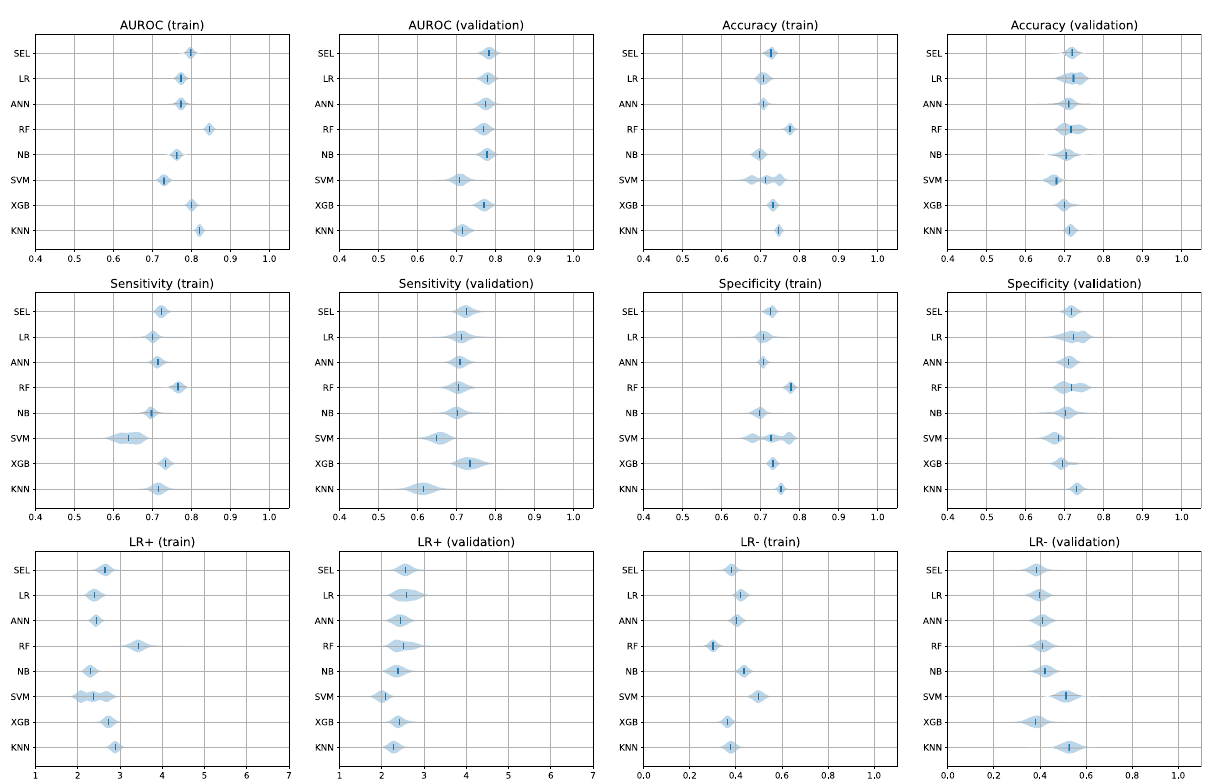
Figure 4. Violin plots of bootstrapped metrics of AUROC, accuracy, sensitivity, specificity, LR+, and LR−. AUROC: area under the receiver operating characteristics curve; LR+: positive likelihood ratio; LR−: negative likelihood